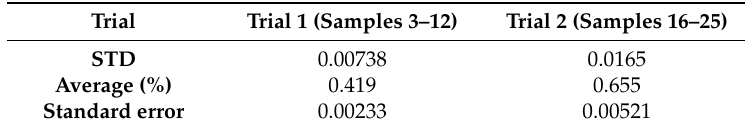
Table 6. The standard deviation, average value and the standard error of the samples with one-minute intervals, for Trial 1 and Trial 2. These data are for the MnO 2 tracer.